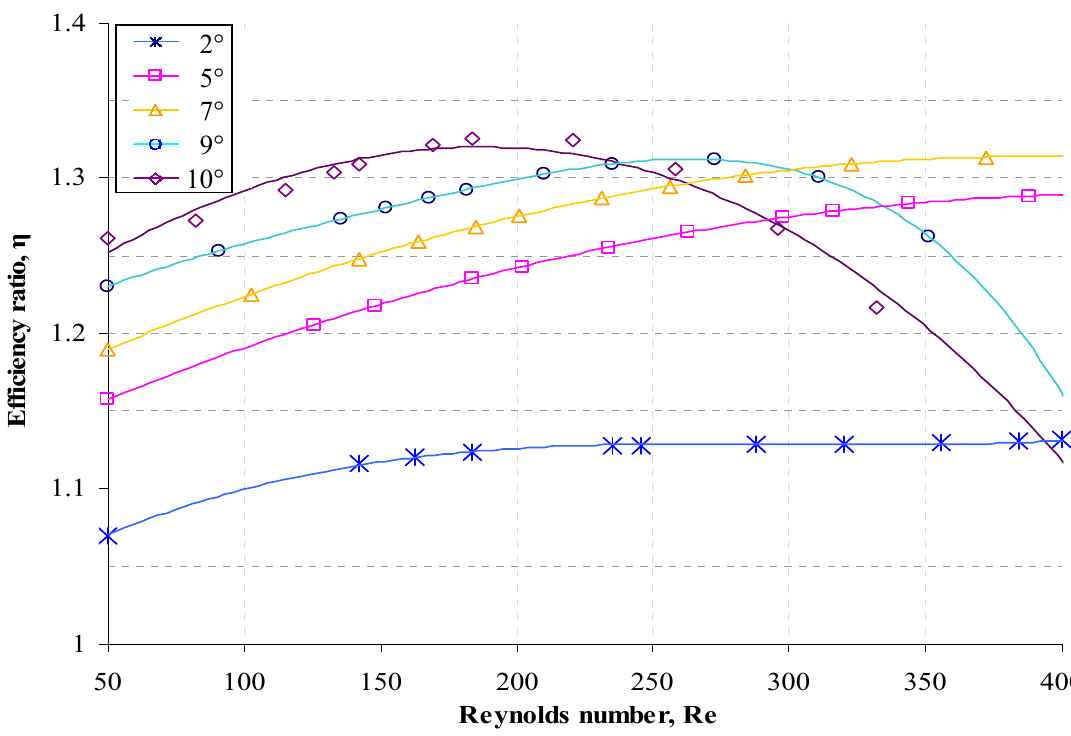
Figure 8. Efficiency ratio of the diffuser element for variation in aspect ratio at different diffuser angle (Re = 200) at a constant actuation pressure of 10